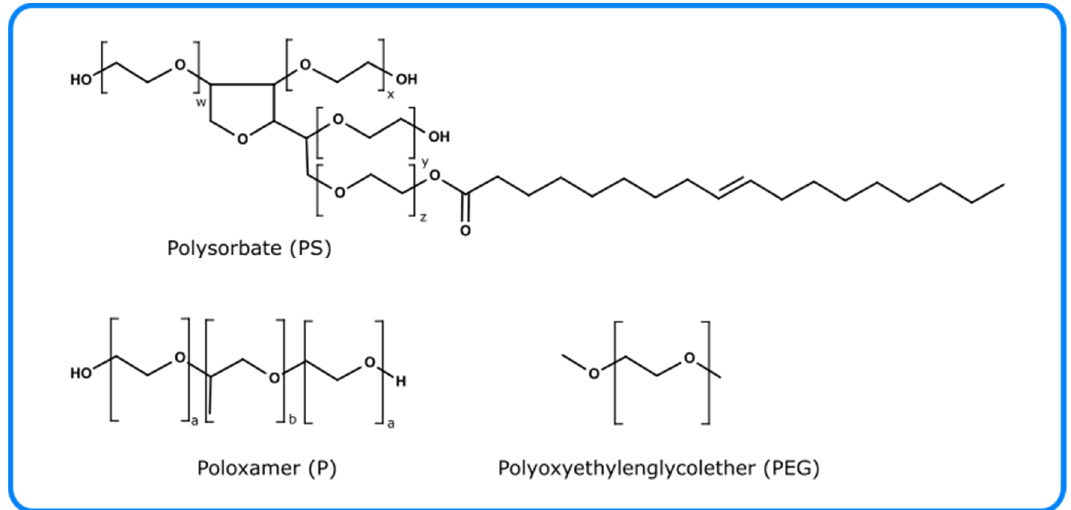
Figure 9. Chemical structure of Polysorbate, Poloxamer, and Polyoxyethyleneglycolether.